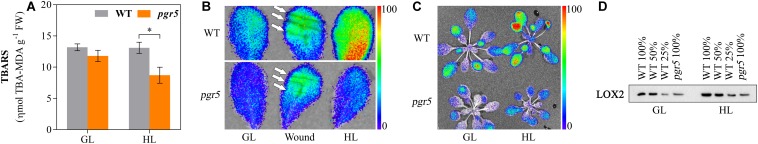
Lipid oxidation in pgr5 mutants after high light treatment. Content of thiobarbituric acid-reactive substances (TBARS; A), autoluminescence imaging (B,C), and Western blotting detection of chloroplast lipoxygenase (LOX2) abundance (D) in WT and pgr5 mutants treated with growth light (GL; 125 μmol m–2 s–1) and high light (HL; 1,000 μmol m–2 s–1) for 1 h. Luminescence intensities (B,C) correspond to color scales as shown. Luminescence images overlay photographs of the same leaf/rosette samples. Wounding of leaves is indicated by white arrows in (B). Error bars show standard error among replicates (n = 4). Significant differences between treatments and genotypes are indicated by asterisks (Student’s t-test, p < 0.05).